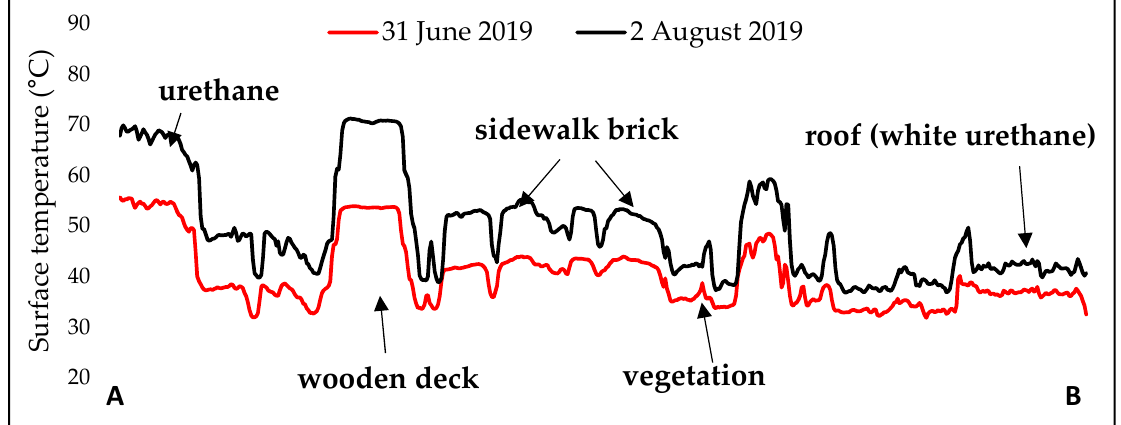
Figure 5. Profile analysis results for line A–B.